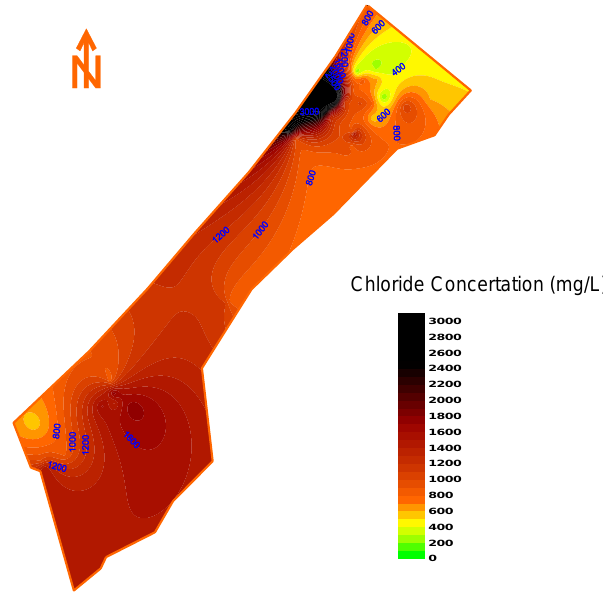
Figure 8. Predicted chloride concentration in 2030 for scenario 1.